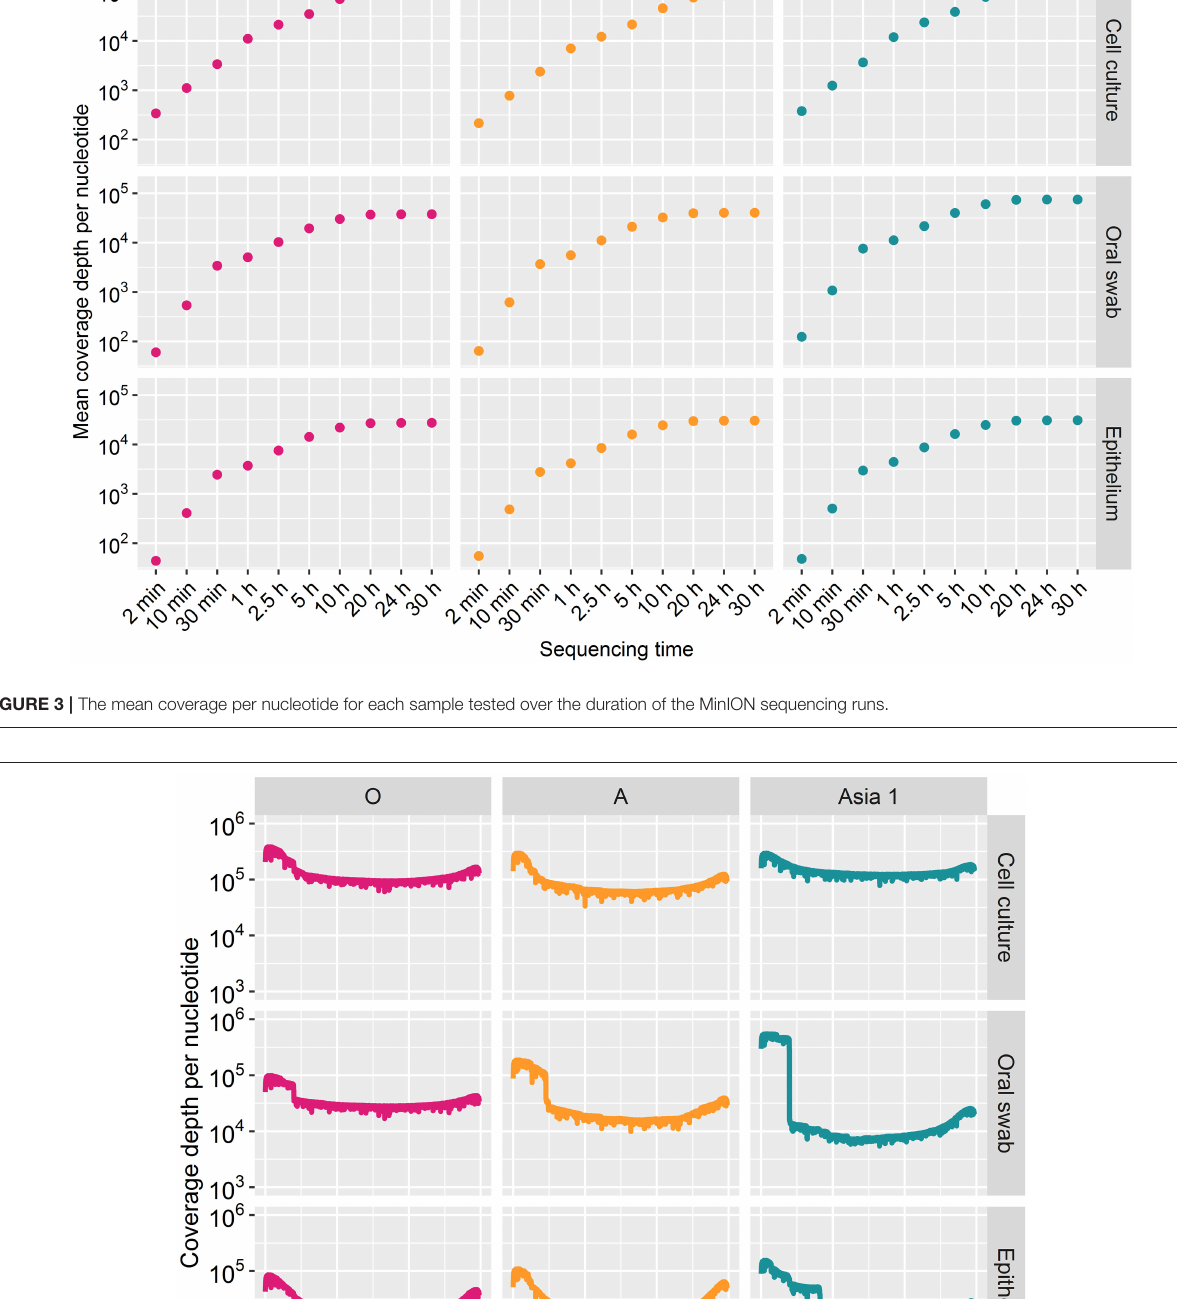
Frontiers in Veterinary Science |